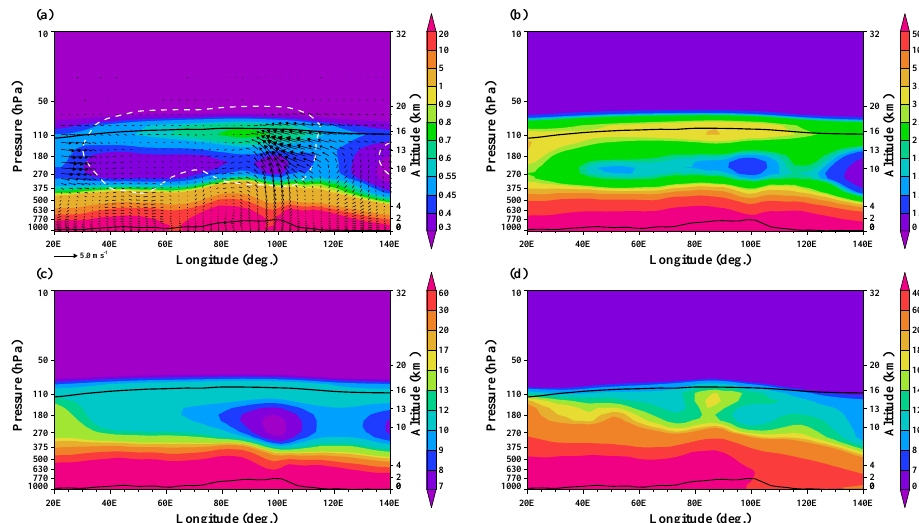
Fig. 2. “cross section” (averaged for June–September and 15–35 ◦ N) of concentrations (ngm − 3 ) of (a) BC aerosols, location of the monsoon anticyclone indicated with dotted line, (b) OC aerosols, (c) SO 2 − , and (d) mineral dust aerosols. Vectors of the circulation are shown in (a) 4 with the vertical wind scaled by 300. The upper black line marks the latitudinally averaged tropopause showing increased height in the ASM region. The lower black line marks the topography. The dashed white line is the negative 10 − 5 vorticity contour showing the approximate region of the anticyclone.